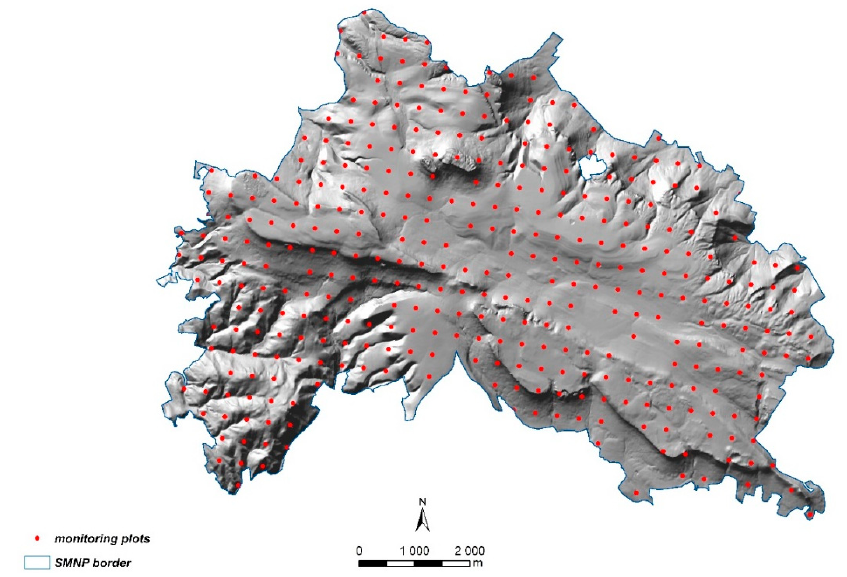
Figure 2. Location of the 387 plots of the primary monitoring network (PMNet). Table 2. Semivariogram model parameters for analysed monitoring networks.